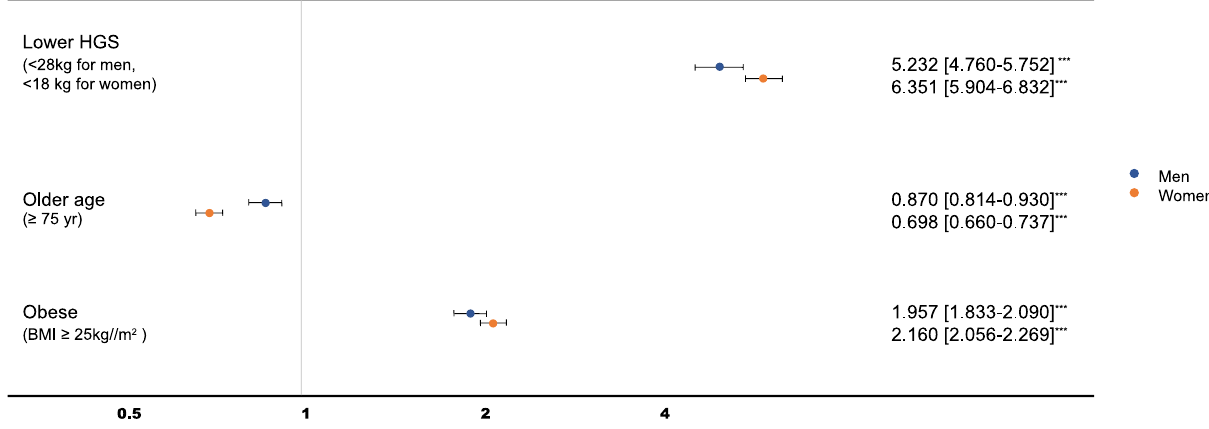
Figure 2. Odds ratio of the lowest level of overall physical fitness. Reference groups were those who were younger (< 75 years), non-obese (BMI < 25 kg/m 2 ), and with higher HGS (≥ 28.0 kg for men and ≥ 18.0 kg for women). *** P < 0.001 through multiple logistic regression analysis. HGS hand grip strength, BMI body mass index, CI confidence